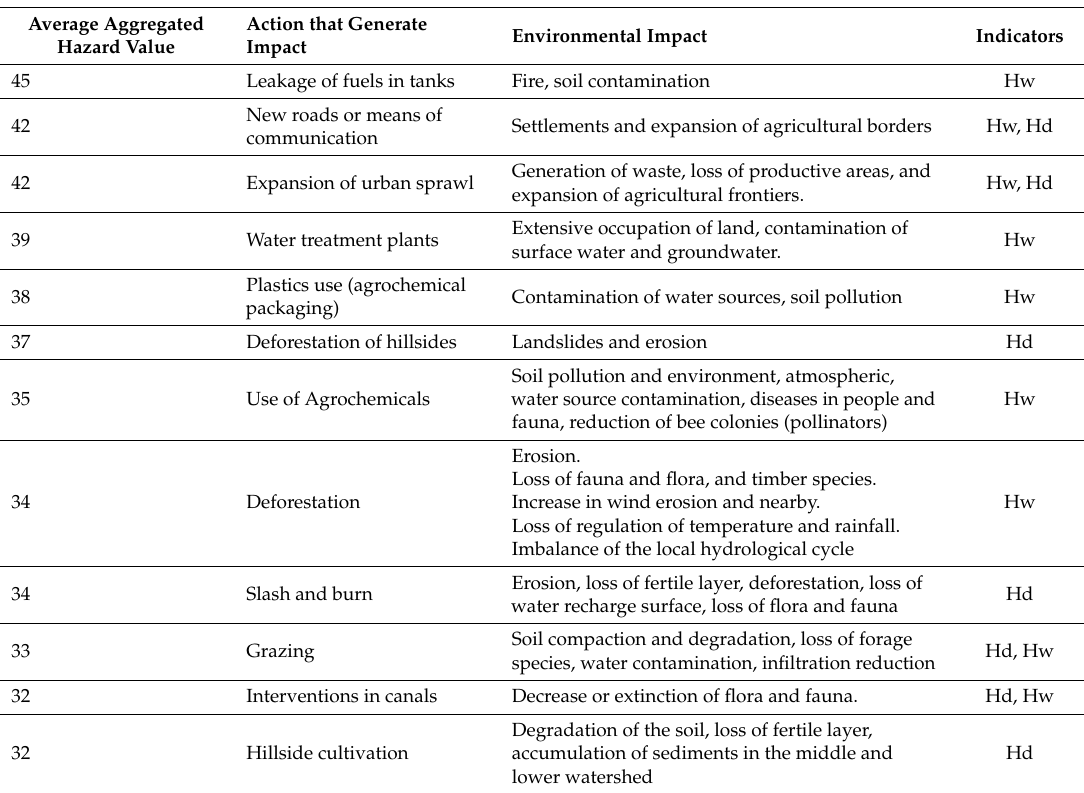
Table A2. Indicators of impact and impact considered—average impact value in the four municipalities considered for the